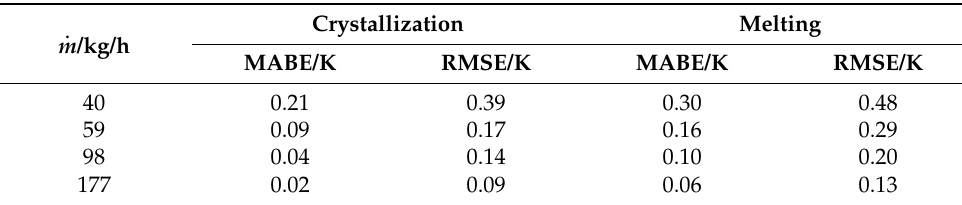
Table 6. MABE and RMSE results for all validation scenarios.